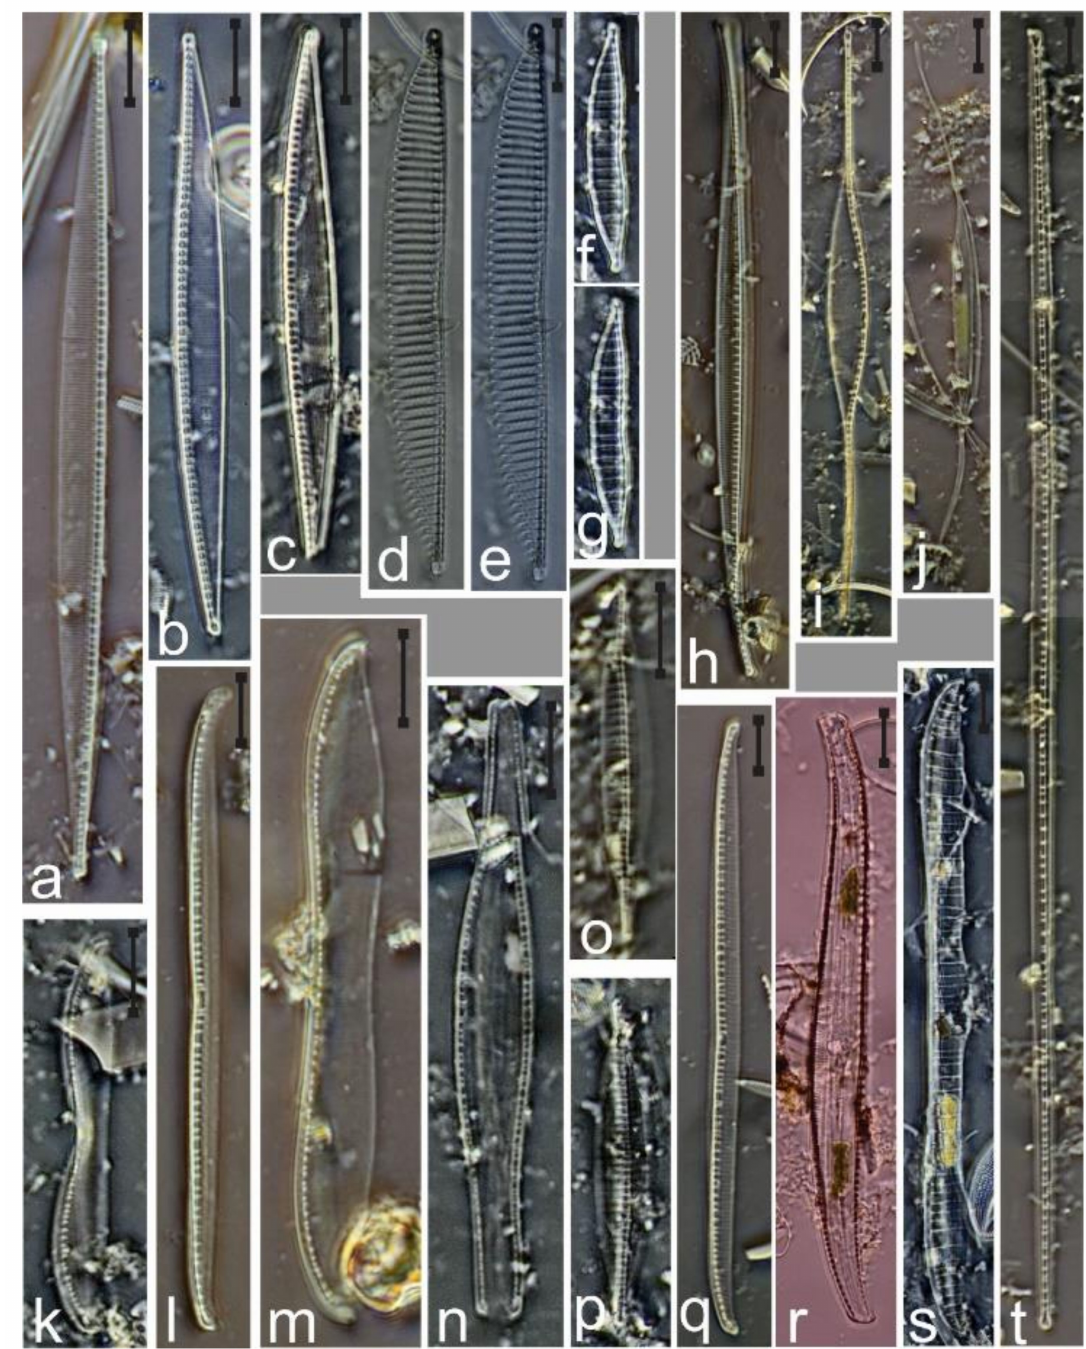
Figure 45. ( a ) Nitzschia fusiformis ; ( b , c ) N. sigma ; ( d – g ) Hantzschia marina ; ( h ) Nitzschia incurva var. lorenziana ; ( i ) N. longissima ; ( j ) Cylindrotheca closterium ; ( k , m ) Nitzschia hybrida ; ( l ) N. linearis ; ( n ) N. lanceolata ; ( o , p ) N. composita ; ( q ) N. cf. spectabilis var. americana ; ( r ) N. insignis ; ( s ) N. costata ; ( t ) N. martiana . Scale bar = 10 µ